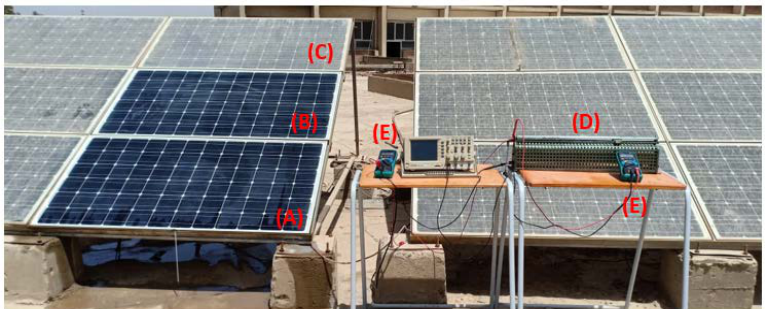
Figure 6. Picture of experimental set-up during measuring work. ( A ) Self-cleaning panel coated with SiO 2 hydrophobic nanomaterial, ( B ) uncoated panel—manual cleaning, ( C ) dusty panel, over all the time of the experiment (reference), ( D ) load (variable resistance) and ( E ) measuring devices.